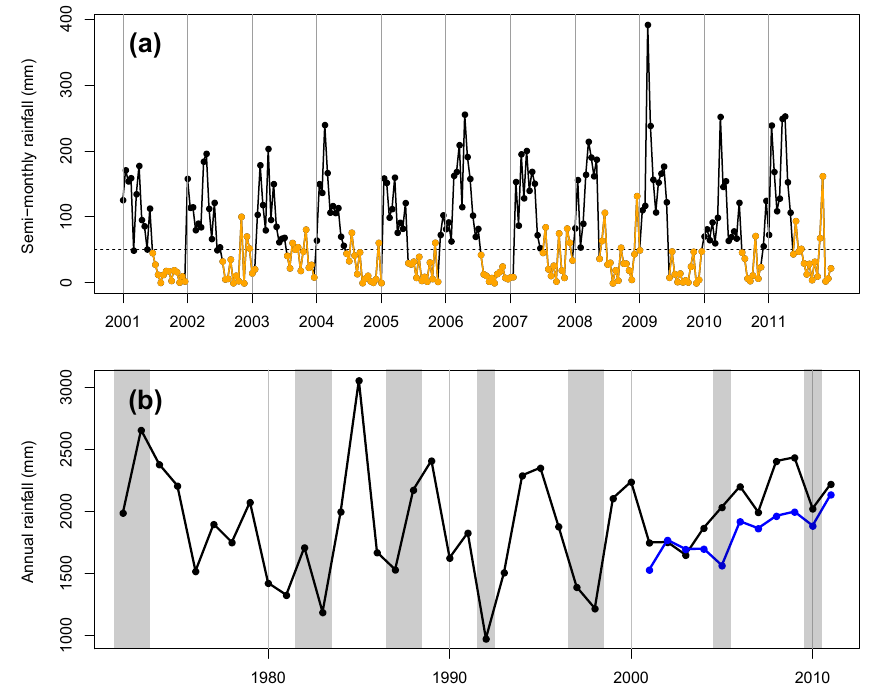
Figure 2. (a) Semi-monthly dry-season rainfall totals for wet season (black) and dry season (orange). Hourly rainfall was estimated by objective analysis (Eq. 1) from meteorology stations near 67km. The horizontal dashed line shows the dry-season threshold of 50mm per half-month. (b) Yearly totals of rainfall from Belterra INMET station (black), 25km away from km67, and km67 rainfall estimated by objective analysis (blue). Recent El Niño anomalies (gray shaded areas) coincide with droughts in the 1990s but not in the 2000s (blue points) at this site, when annual rainfall was within the long-term historical